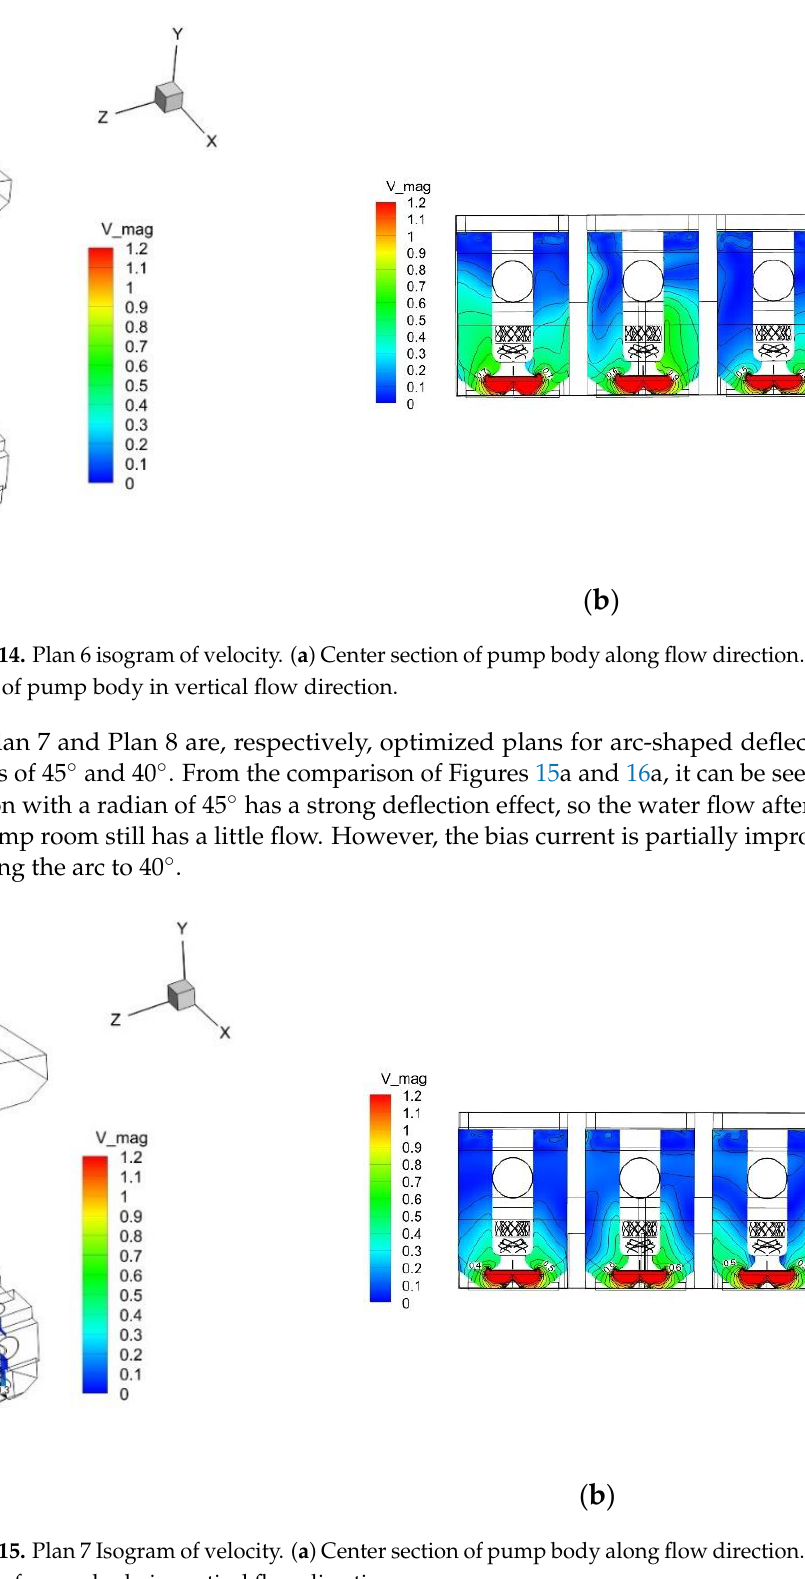
( b ) Figure 16. Plan 8 isogram of velocity. ( a ) Center section of pump body along flow direction. ( b ) Center section of pump body in vertical flow direction. In Plan 8, the difference in water flow velocity between the front and rear edges of the circulating pump bellmouths is partially improved. In addition, from Figure 15b and Figure 16b, it can be seen that the improvement effect of the arc deflector on the flow ve- locity of the left and right sides of the circulating pump bellmouth is better than that of the Plan 5. Plan 9 and Plan 10 are the improvement of the arc-shaped deflectors with the same radian of 35° but different heights and widths. Compared with Plan 8, the uniformity and stability of the flow state are greatly improved after the radian is further reduced to 35°. It can be seen in Figures 17a and 18a that the flow velocity difference between the front and rear edges of the circulating pump bellmouth is minimal. From the compari- son between Figures 17b and 18b, increasing the height of the deflector can improve the flow velocity difference between the left and right sides of the circulating pump bell- mouth. As can be seen from Figure 18b, the flow rate around the circulating pump bell-